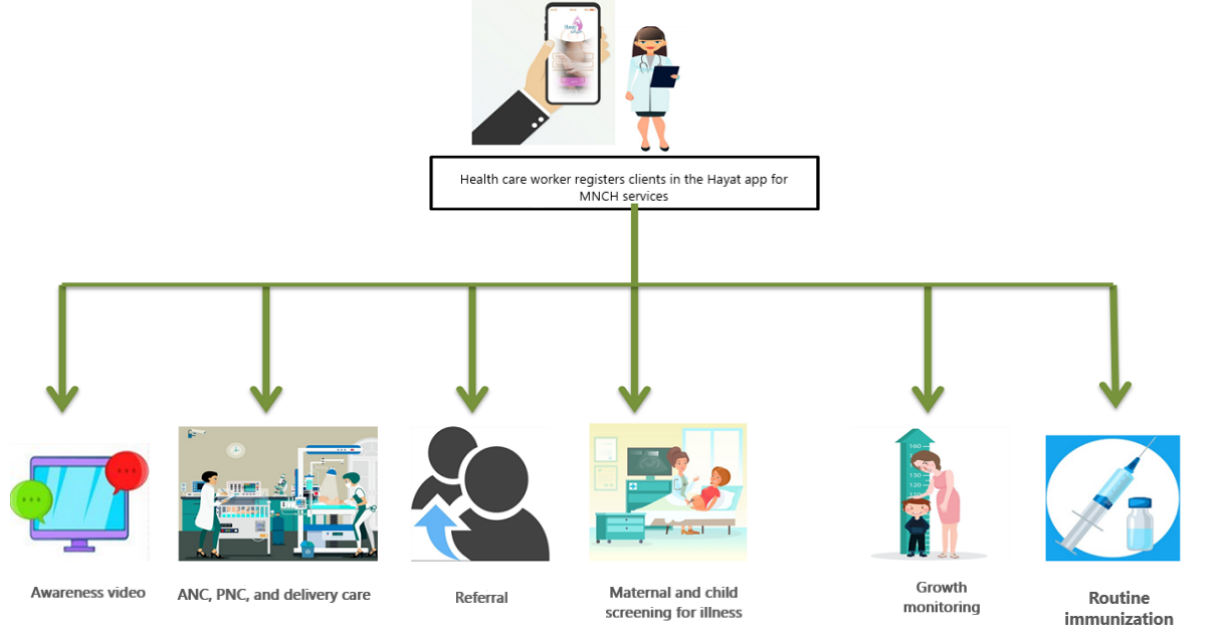
Figure 1. Workflow of the Hayat app for community health workers. ANC: antenatal care; MNCH: maternal, newborn, and child health; PNC: postnatal care.